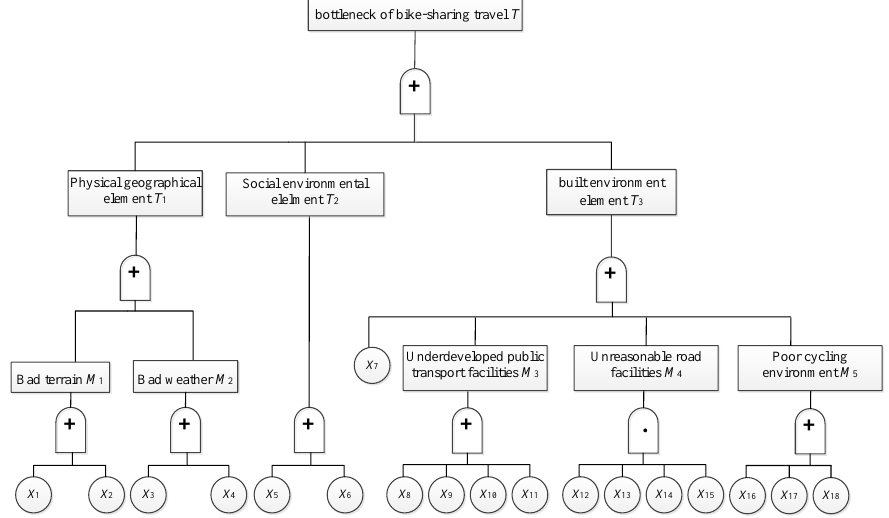
Figure 7. The fault tree model for bottlenecks of bike-sharing travel.